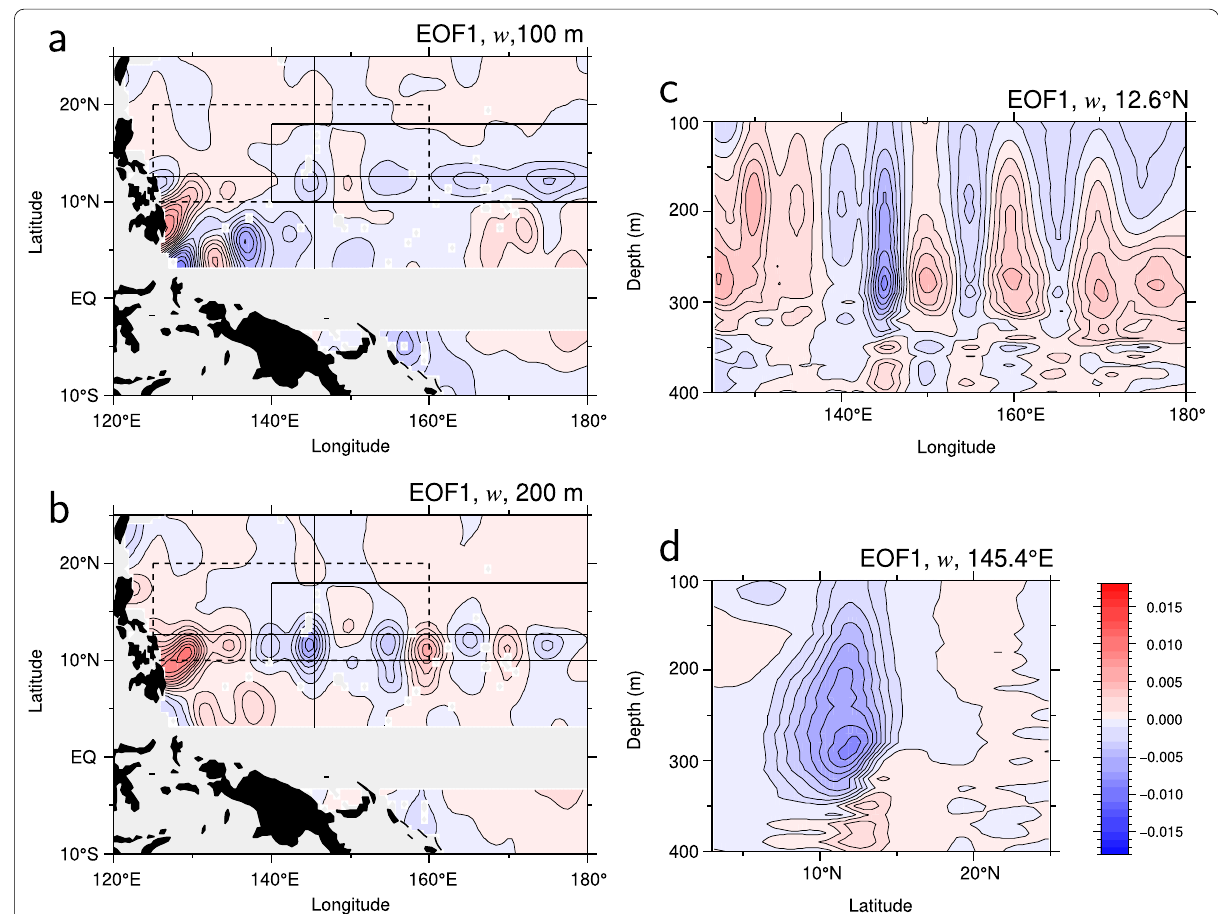
Fig. 10 First EOF mode of vertical velocity w in the region of 10 ◦ – 25 ◦ N, 120 ◦ E– 180 ◦ and the layer from 100 to 1000 m depths. The w data were smoothed by a 15-month running mean filter. Loadings of the EOF mode at depths of 100 m and 200 m are shown in panels a and b , respectively. Dotted square delineate the region where Nagano et al. (2016a) studied the QD variation and solid square the region (Region A) where we calculated vertical volume and temperature transports and SST tendency due to vertical current variation as in Fig. 14. Sections of the EOF mode loading at zonal 12.6 ◦ N and meridional 145.4 ◦ E lines (thin solid lines) in a and b are indicated in panels c and d , respectively. Contour intervals are